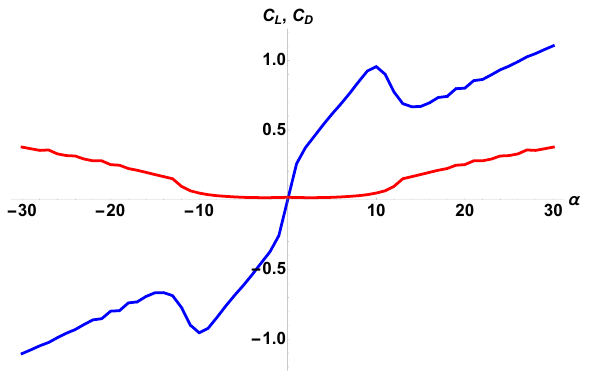
Fig. 5. The lift (blue line) and drag (red line) coefficients generated using XFLR5 software [22] for the symmetric hydrofoil NACA0012